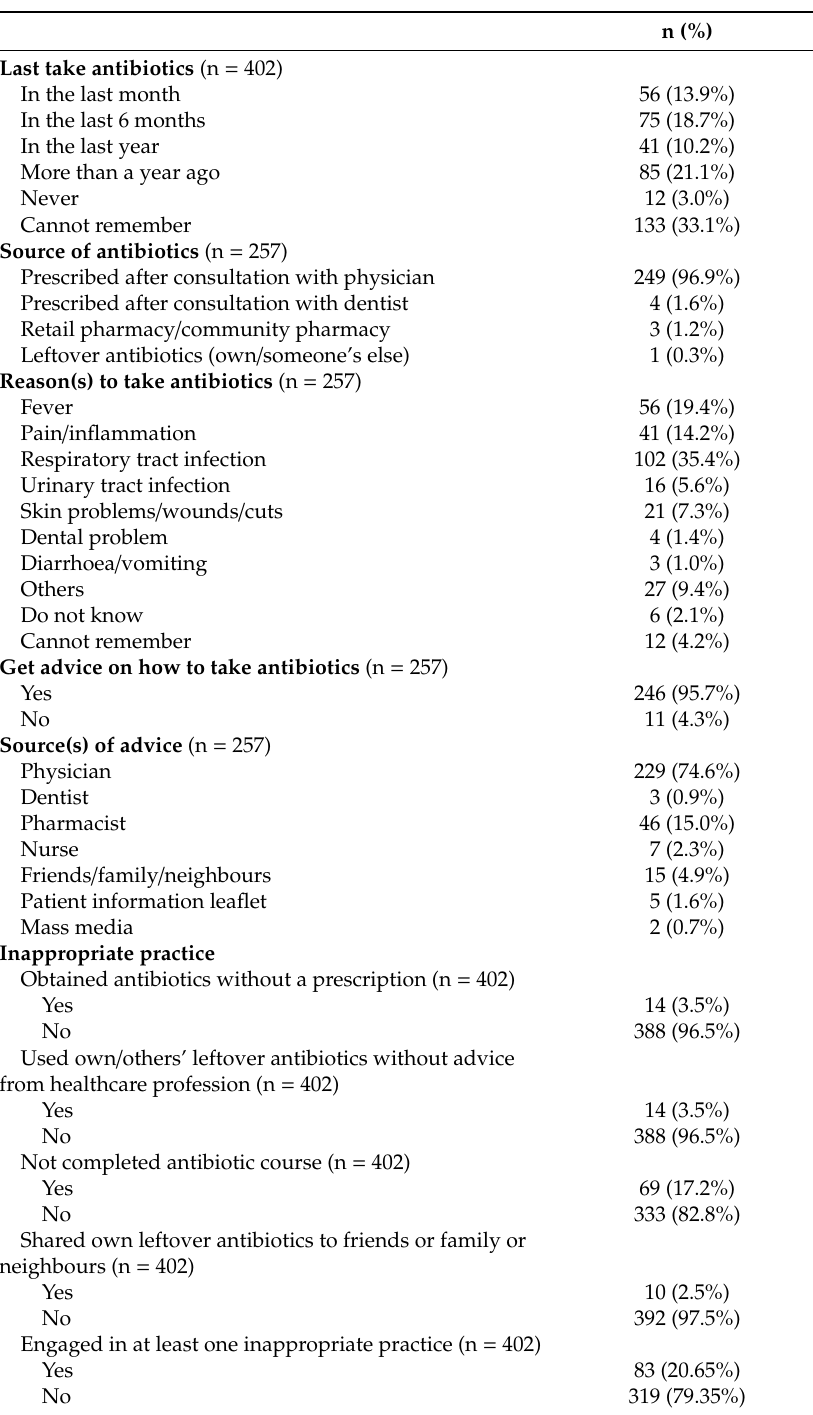
Table 2. Prior experience in antibiotic